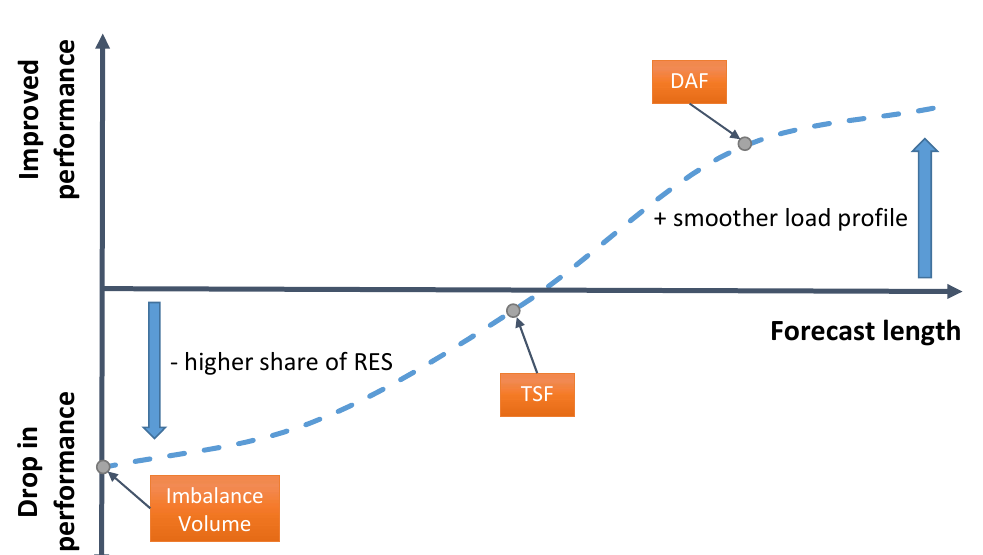
Figure 14. Illustrative effect of the lockdown on the forecast accuracy compared to pre-action weeks. TSF and DAF indicate the transmission system forecast and total day-ahead forecast, respectively, as described in Section